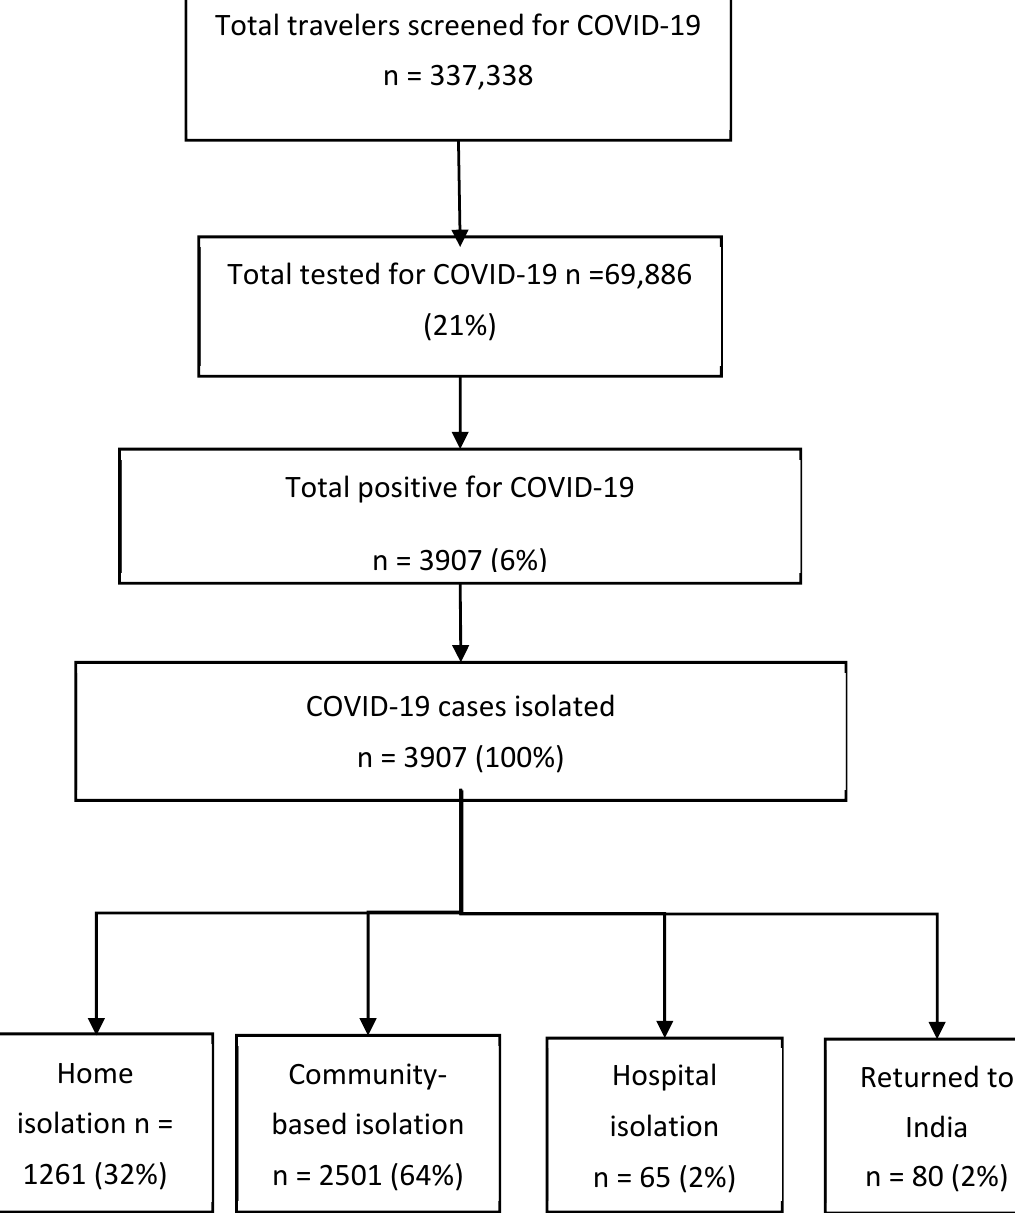
Figure 2. Numbers of travelers screened, tested and diagnosed with COVID-19 along with types of isolation for the management of COVID-19 at 13 POE in Nepal: 19 March 2021–15 July 2021. COVID-19 = Coronavirus Disease-19; POE = Points of